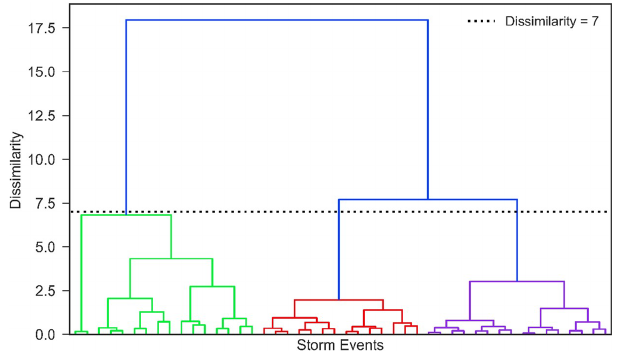
Figure 9. Tree-based dendrogram of agglomerative clustering; green, red, and purple lines represent within-cluster dissimilarities in light, moderate, and severe storms, respectively.